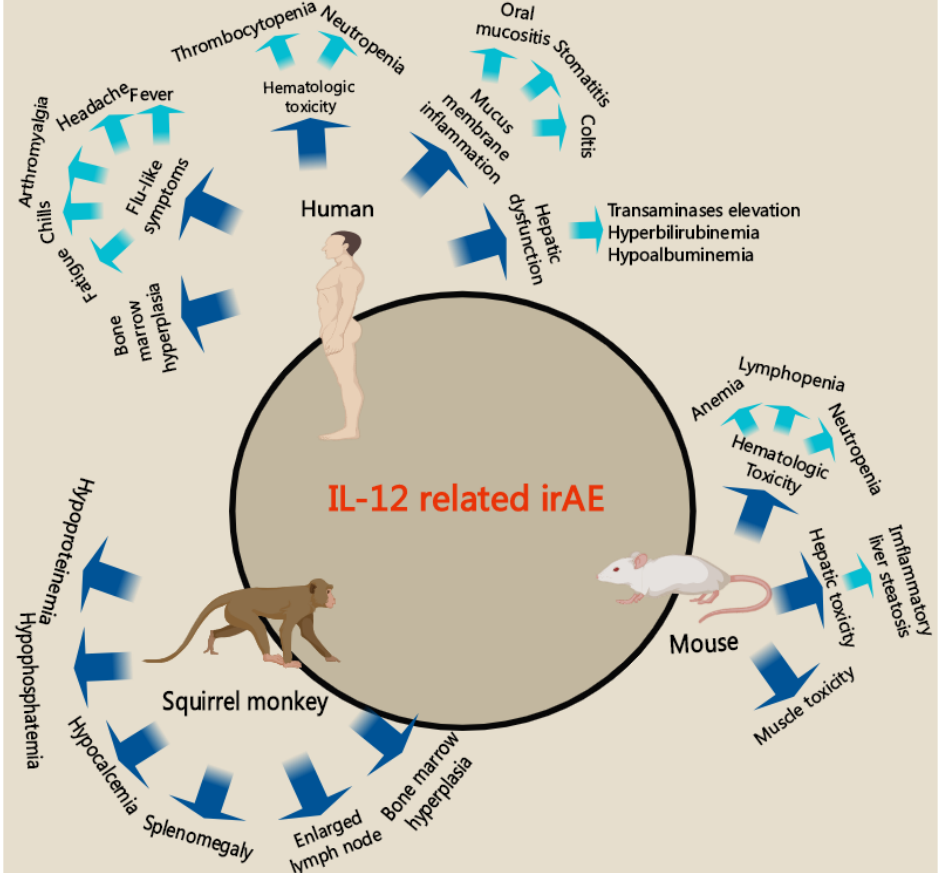
Figure 3. IL-12 related irAE. In clinical trials of patients with cancer, hematologic toxicity, inflammatory liver steatosis, flu-like symptoms, mucus membrane inflammation, bone marrow hyperplasia are found the major side effects. In preclinical experiments with mouse tumor models, hematologic toxicity, inflammatory liver steatosis and muscle toxicity are seen. However, hypoproteinemia, hypophosphatemia, hypocalcemia, splenomegaly, enlarged lymph node and bone marrow hyperplasia are the most common irAE seen in squirrel monkeys.